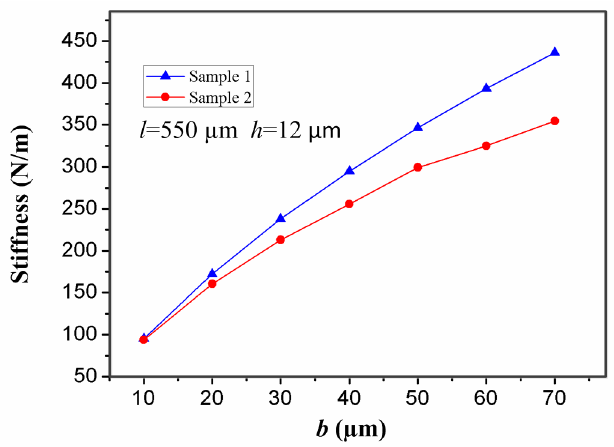
Figure 9. Effect of the width ( b ) of the stationary electrode in samples 1 and 2 on the stiffness of the stationary electrode when the thickness ( b ) and the length ( l ) of the stationary electrode are set as 12 µm and 550 µm, respectively.